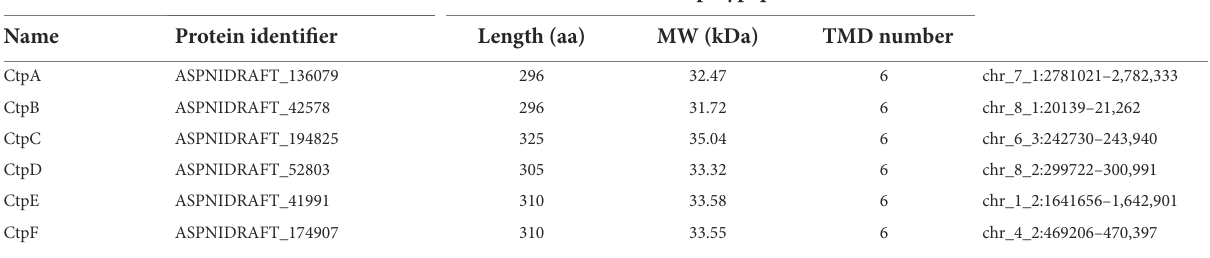
TABLE 2 Characteristics of Ctps in Aspergillus niger